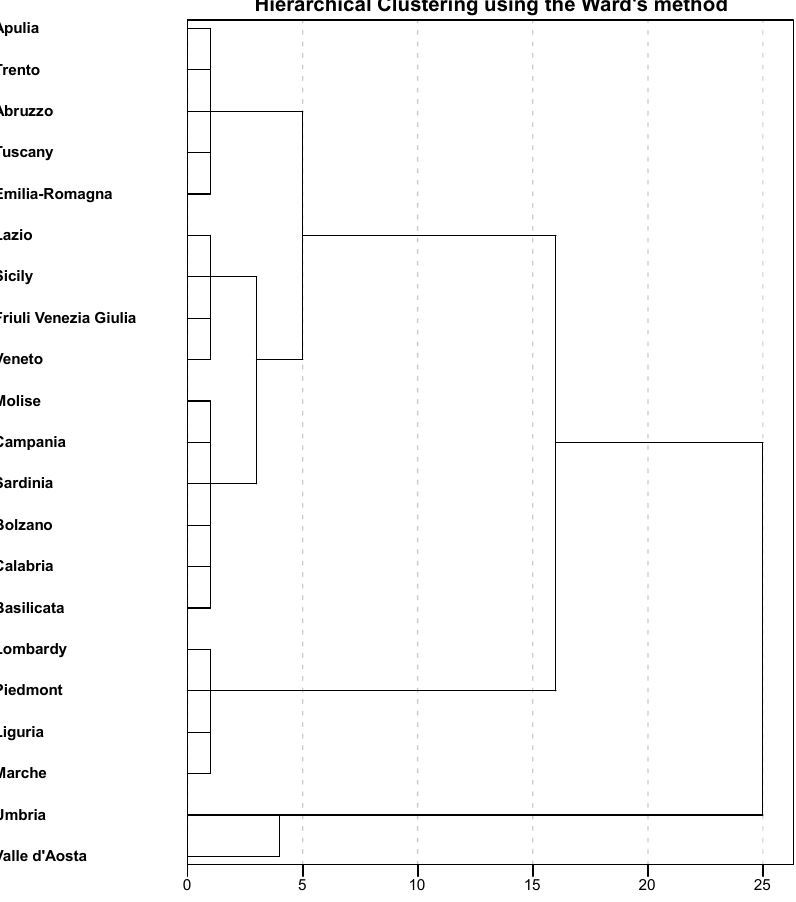
Figure 3. Dendrogram of the hierarchical clustering of regions based on Ward’s criterion. Table 2. Average silhouette width for the hierarchical clustering of regions.